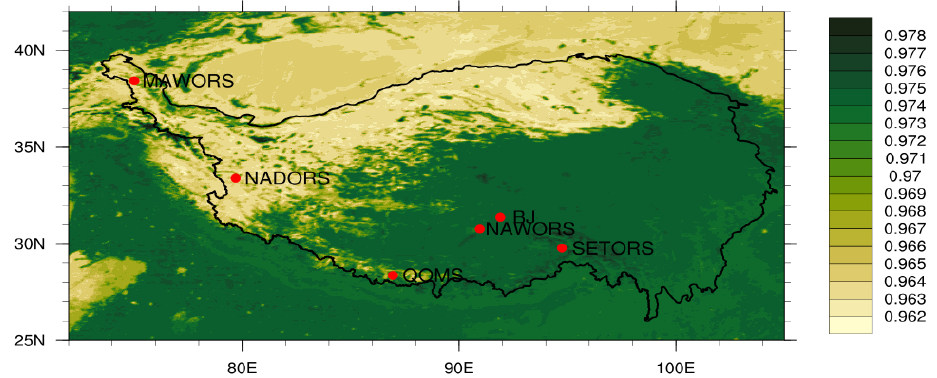
Figure 2. Surface emissivity and station distribution in the observation area.